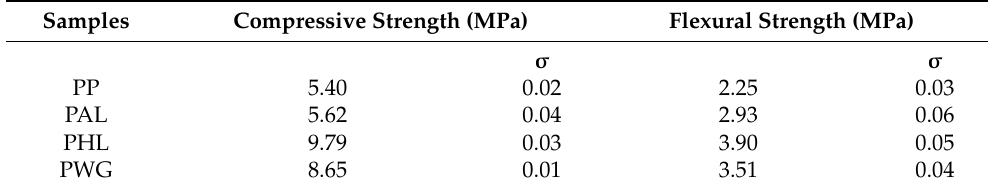
Table 6. Results of the mechanical tests (120 days) and standard deviation for the different pastes tested.